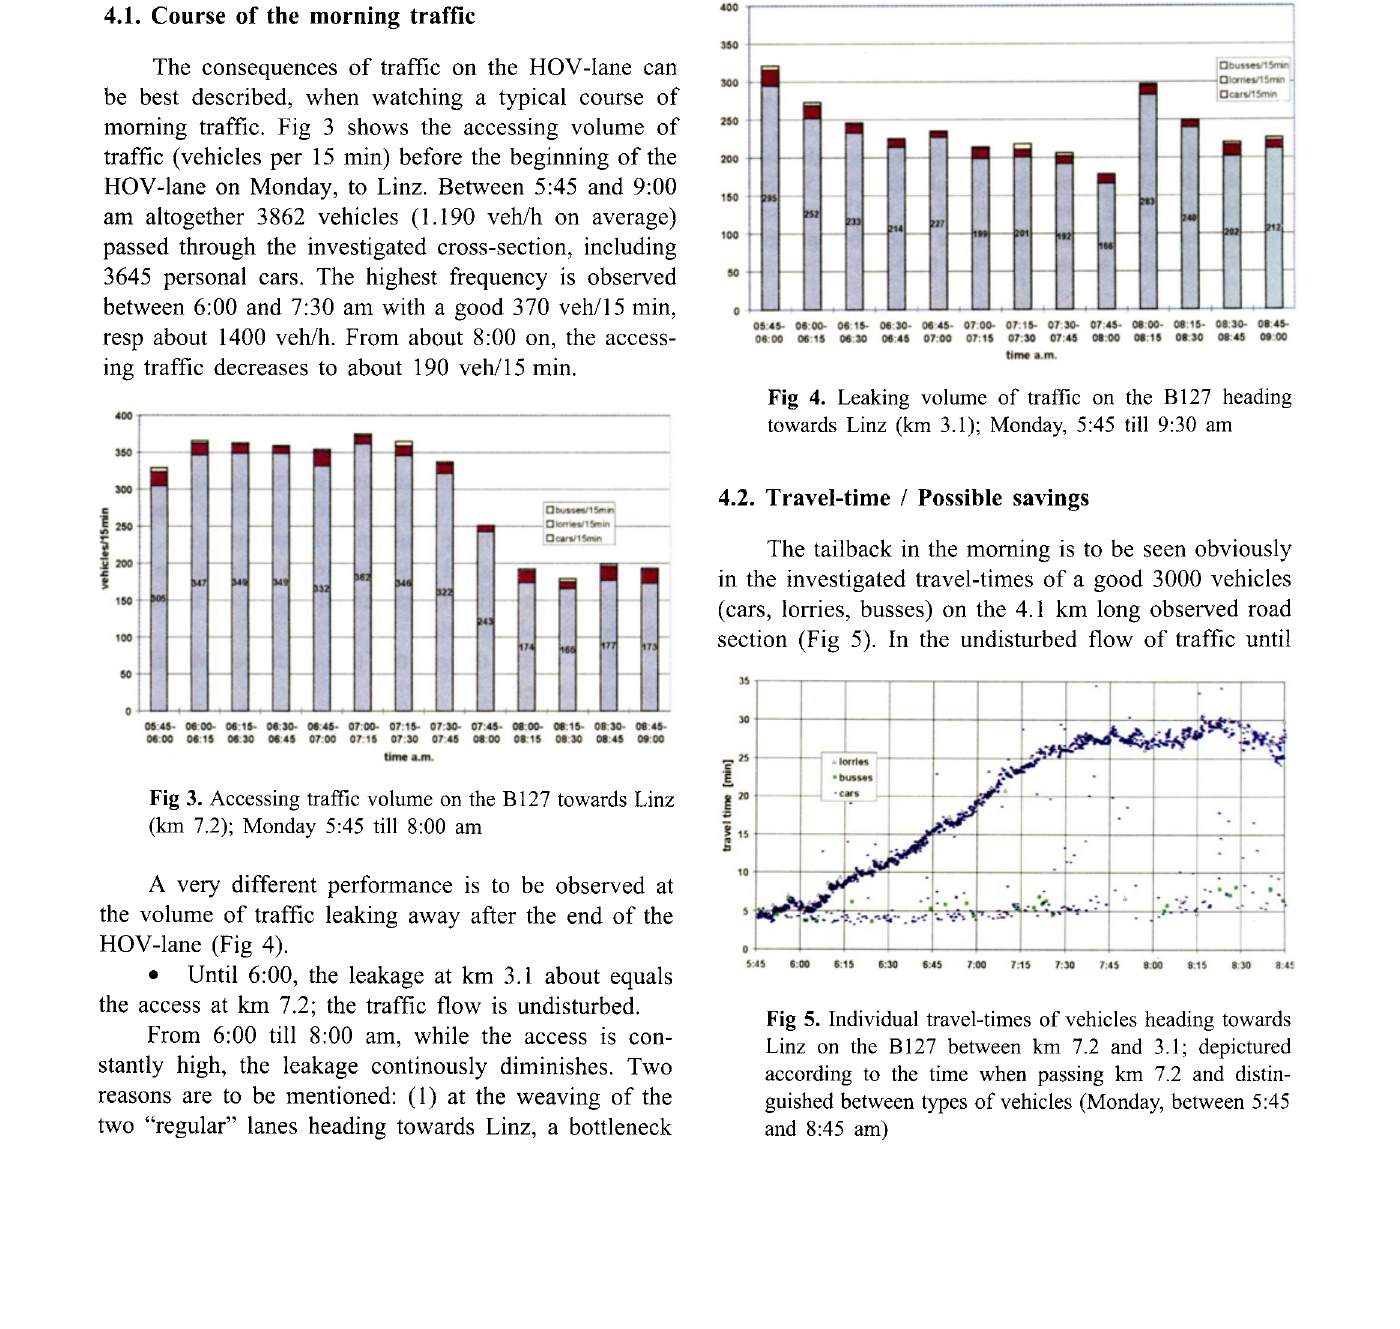
Fig 5. Individual travel-times of vehicles heading towards Linz on the Bl27 between km 7.2 and 3.1;